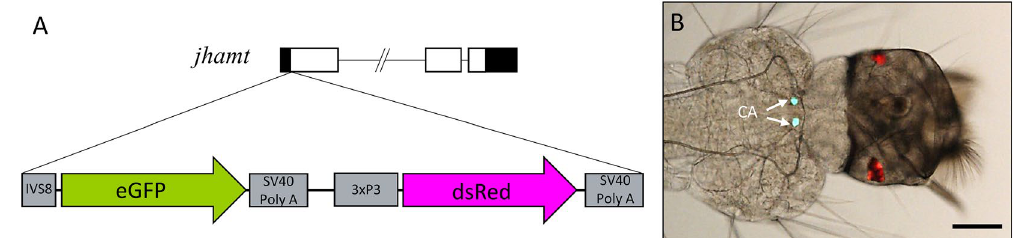
Figure 1. Integration of a promoter-less transgene encoding eGFP into the jhamt locus. ( A ) Diagram of the pSL_jhamt_eGFP construct. eGFP was flanked by the synthetic intron IVS8. dsRed (RFP) was used as a selection marker under the control of 3xP3, which drives expression in the eye. The insert was surrounded by two 1.5 kb jhamt locus homologous arms to facilitate recombination. ( B ) Image of head and thorax of a first instar larvae showing expression of dsRed in eyes and eGFP in the CA. Scale bar, 100